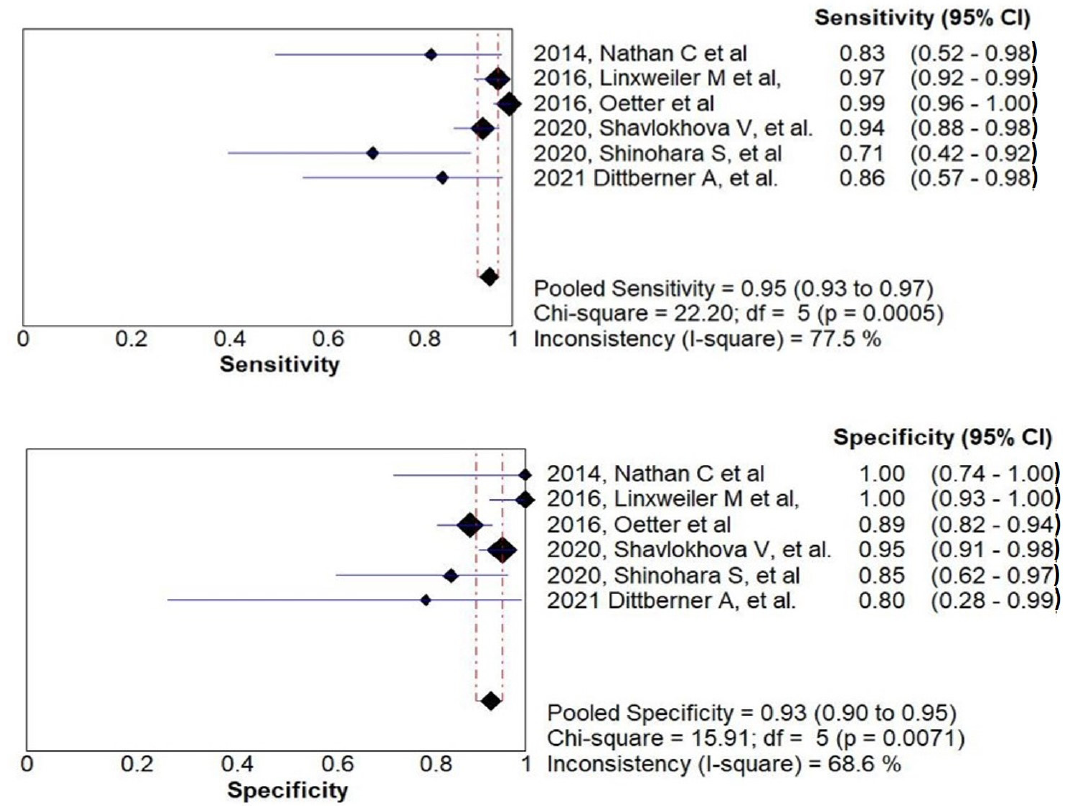
Figure 2. Forest plots for each specific study and their pooled estimates of sensitivity and specificity with their heterogeneity statistics of confocal laser endomicroscopy for the diagnosis of oral squamous cell carcinoma. 6.24–1554.1) and the negative likelihood ratio extended from 0.008 (95% CI,